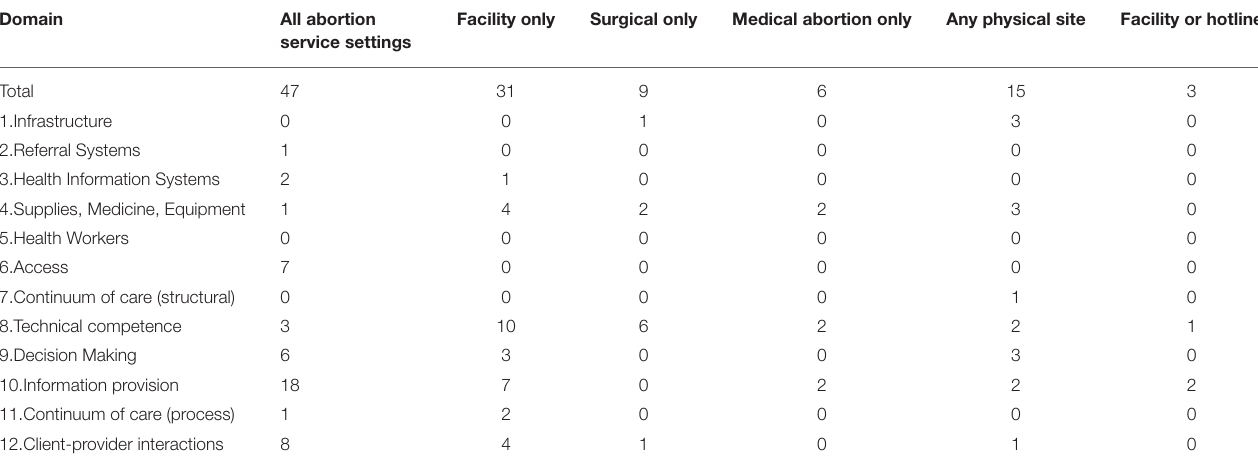
TABLE 3 | Applicable indicators by domain and care group.